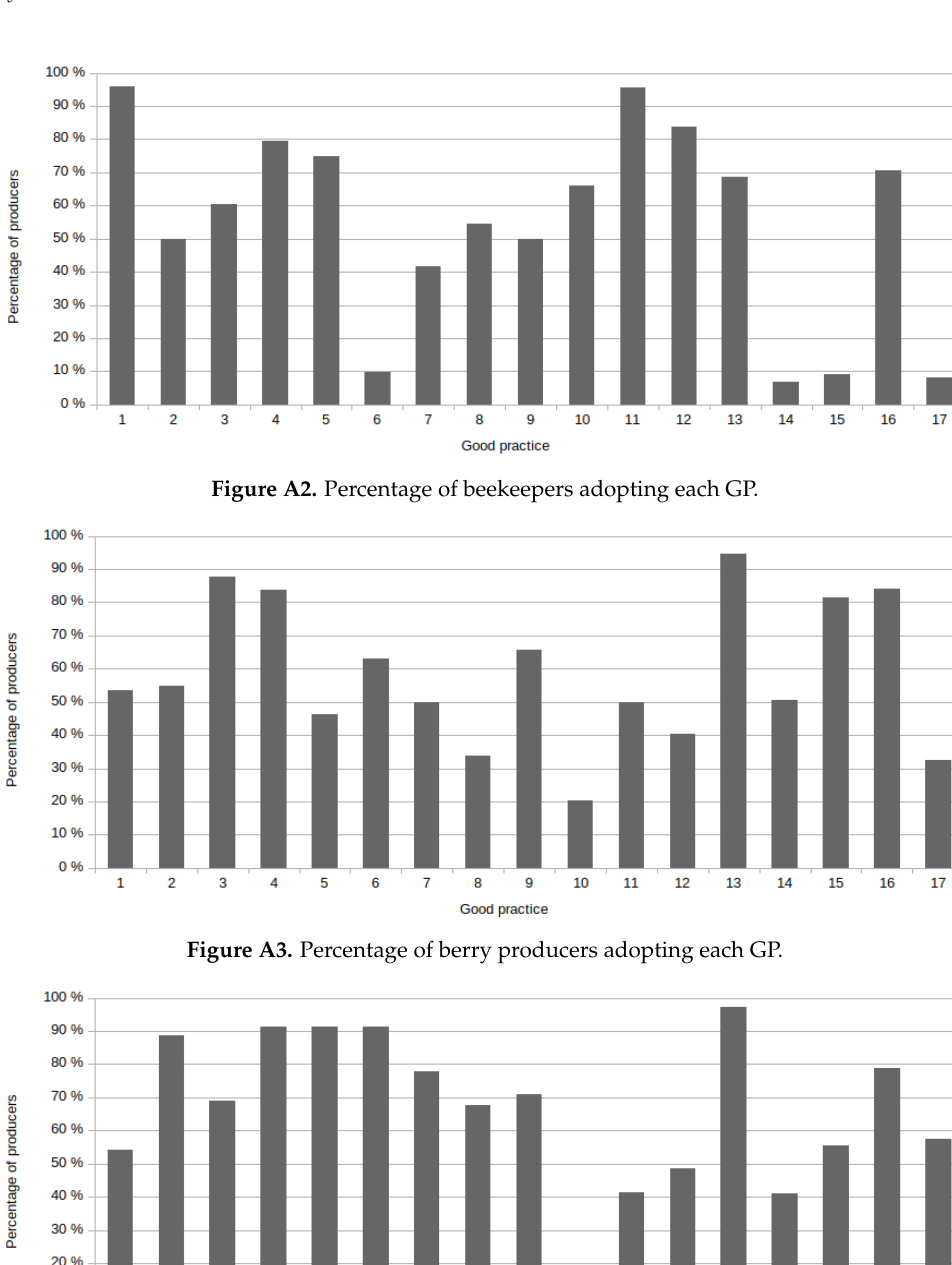
Figure C1. Percentage of dairy producers adopting each GP.